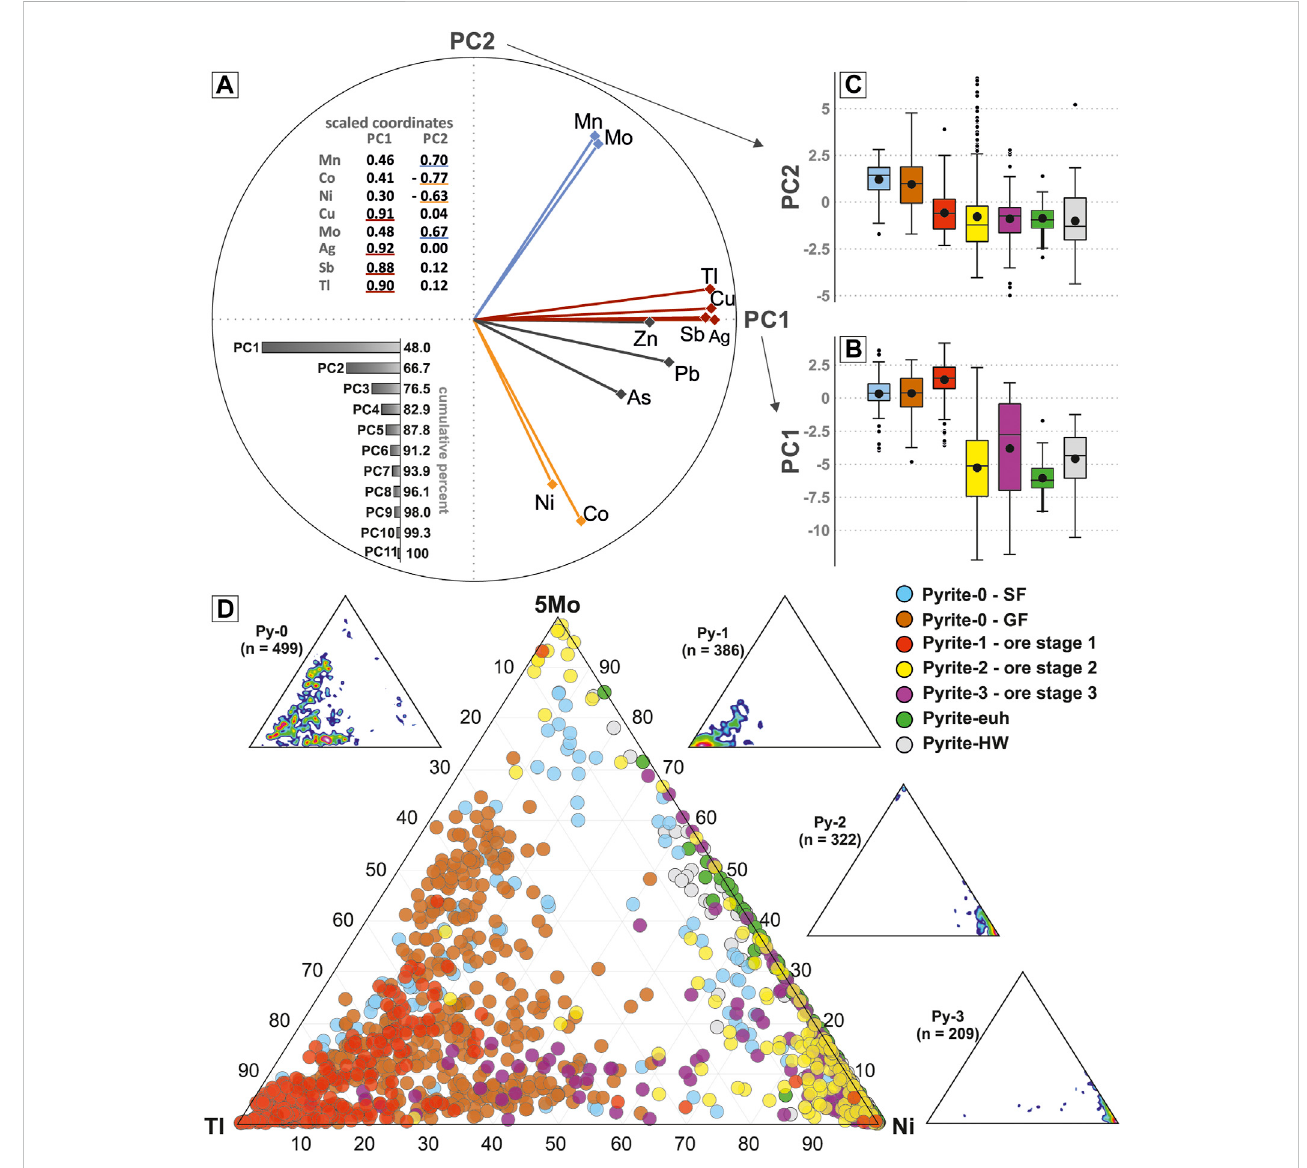
FIGURE 11 (A) Principal component diagram for the pyrite trace element data. Shown are the 2-dimensional representation of the data for PC1 and PC2, respective scaledcoordinatesforPC1andPC2,andthecumulativepercentagesforstatisticalsigni fi canceoftheindividualprincipalcomponents. (B – C) Boxandwhisker plots of PC1 (B) and PC2 (C) values for the individual pyrite sub-types. For details of the statistical method for box and whisker plots see Figure 8. (D) Ternary diagram of Tl, Ni, and 5*Mo abundances for the individual pyrite sub-types. The distribution of the data for Py-0, Py-1, Py-2, and Py-3 is also denoted in individual point density ternary